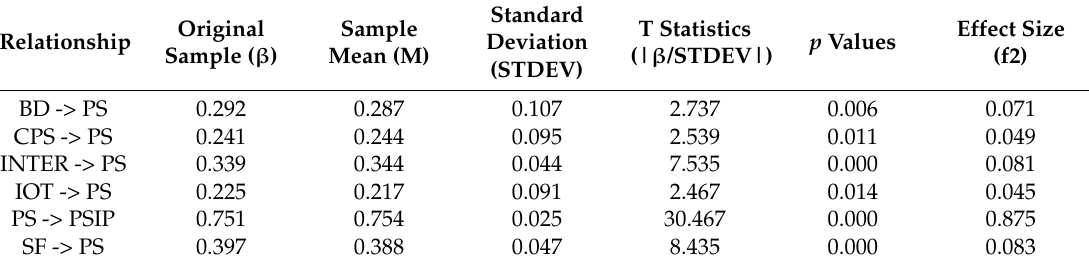
Figure 6. Structural model. Table 5. Structural model (results).